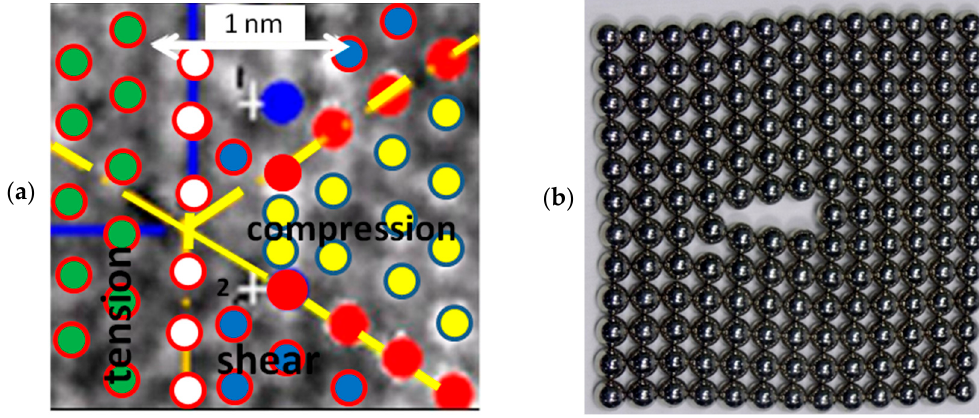
Figure 12. ( a ) Locations of atoms in the crystal region with the dislocation; ( b ) simulation of the presence of a dislocation using magnetic spheres [36].